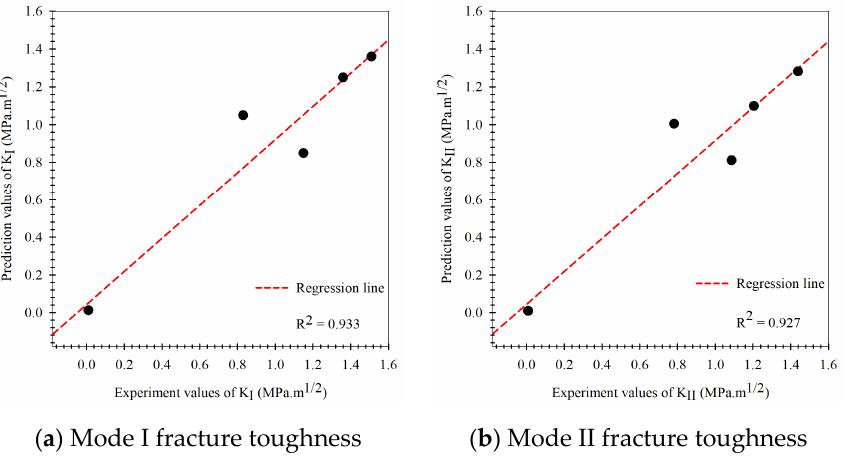
Figure 11. Prediction results of the multi-fidelity surrogate model based on the ASED criteria compared to the experiment results.